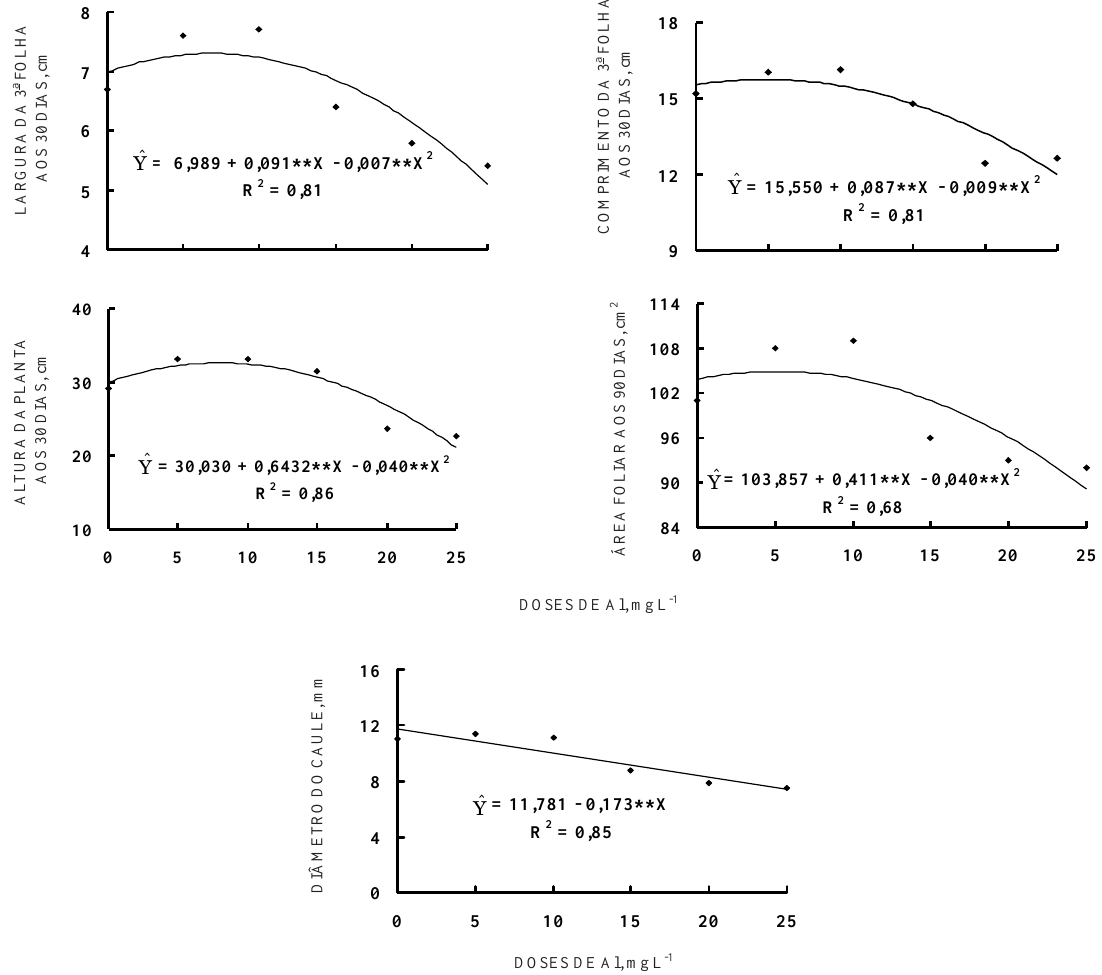
Figura 1. Biometria de largura e comprimento da 3 a folha, altura da planta, aos 30 dias; área foliar da 3 a folha, aos 90 dias e, diâmetro do caule, aos 110 dias de mudas de goiabeira (* significativo a